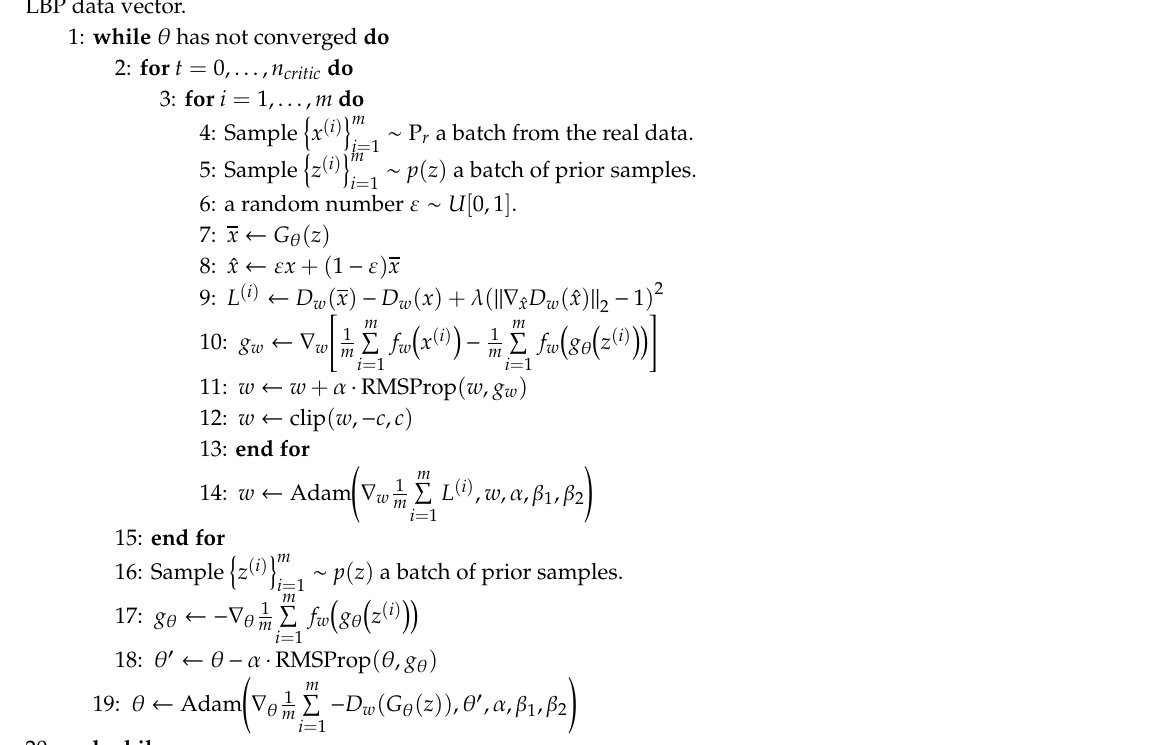
= 25, λ = 10, β = 0, β = critic 1 2